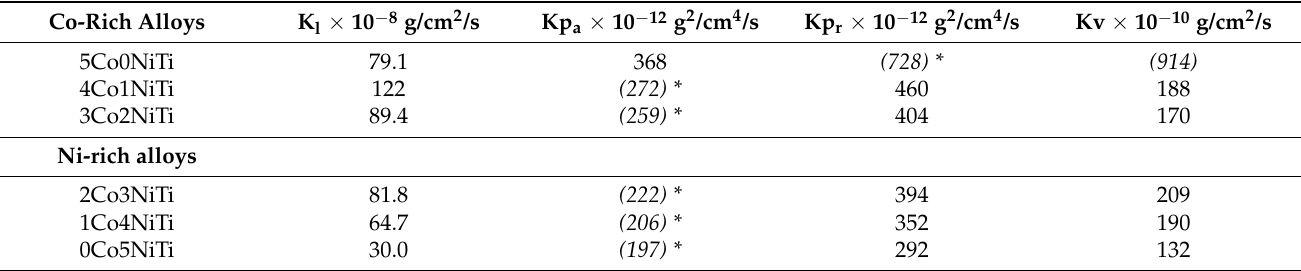
*: between parentheses and written in italics: corresponding indicative values of Kp a , Kp r and Kv obtained by the other determination method (less representative).